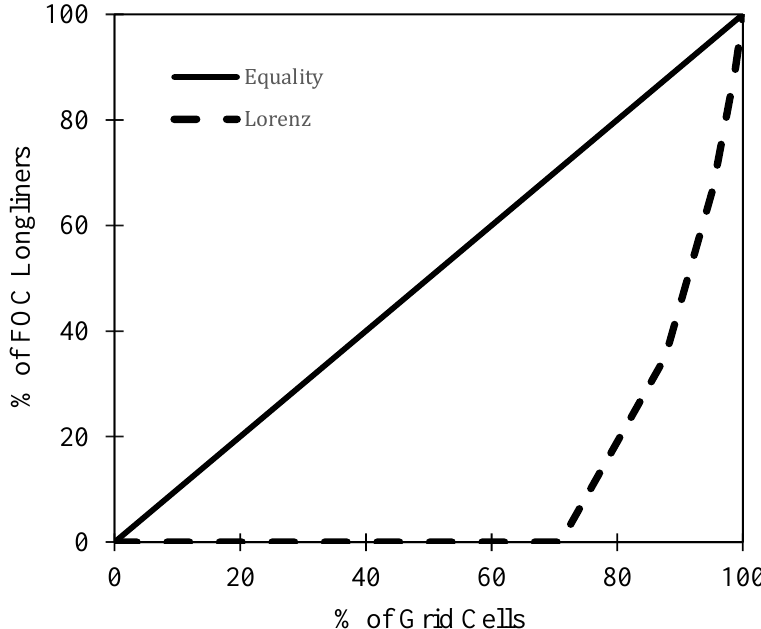
Figure 3. The inequality of FOC longliner presence across ocean grid cells in 2016. The Lorenz line (dotted) significantly deviates from the line of equality, demonstrating that FOC longliner presence is spatially concentrated in a small number of grid cells (Gini = 0.786). More specifically, 29% of at-sea grid cells experienced the presence of at least one FOC longliner, and this 29% accounted for 100% FOC longliner presence